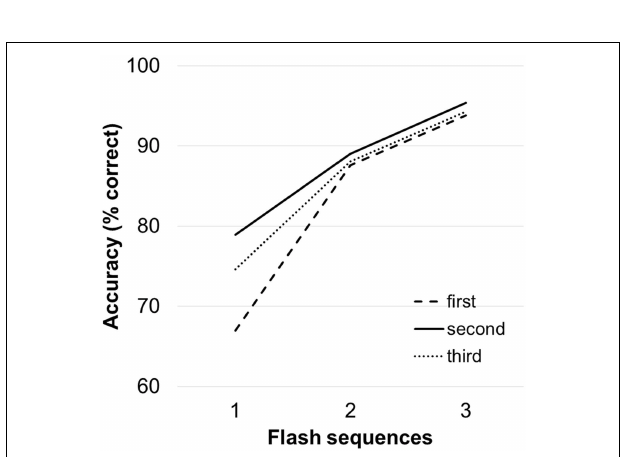
FIGURE 3 | Average accuracies as a function of order of presentation (first, second, third) independent of the display method. Accuracies were calculated offline (for three sequences these values are equal to the accuracies achieved during online